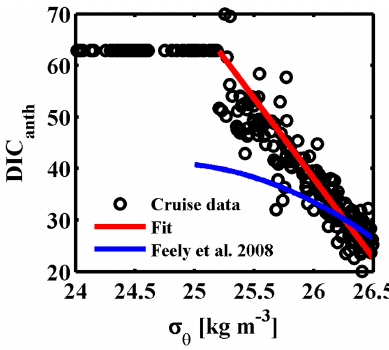
Figure 4. DIC anth as a function of σ θ . The calculated values and the fit are represented by black circles and a red line, respectively. The blue line shows DIC anth using the formulations from Feely et al.